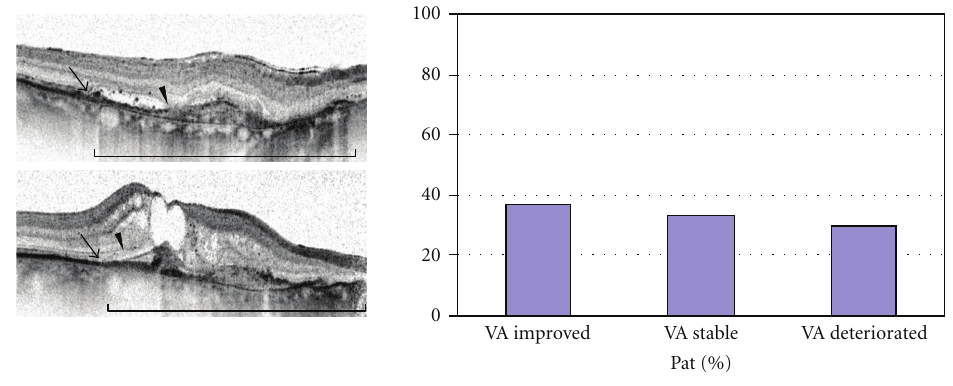
Figure 3: Group of patients with poor continuity of ELM and IS/OS over the CNV lesion: exemplary baseline OCT images and final distribution of patients with improved, stable, or decreased vision after triple intravitreal ranibizumab therapy (Brackets define the area of the CNV lesion. Arrowheads = ELM. Arrows = IS/OS